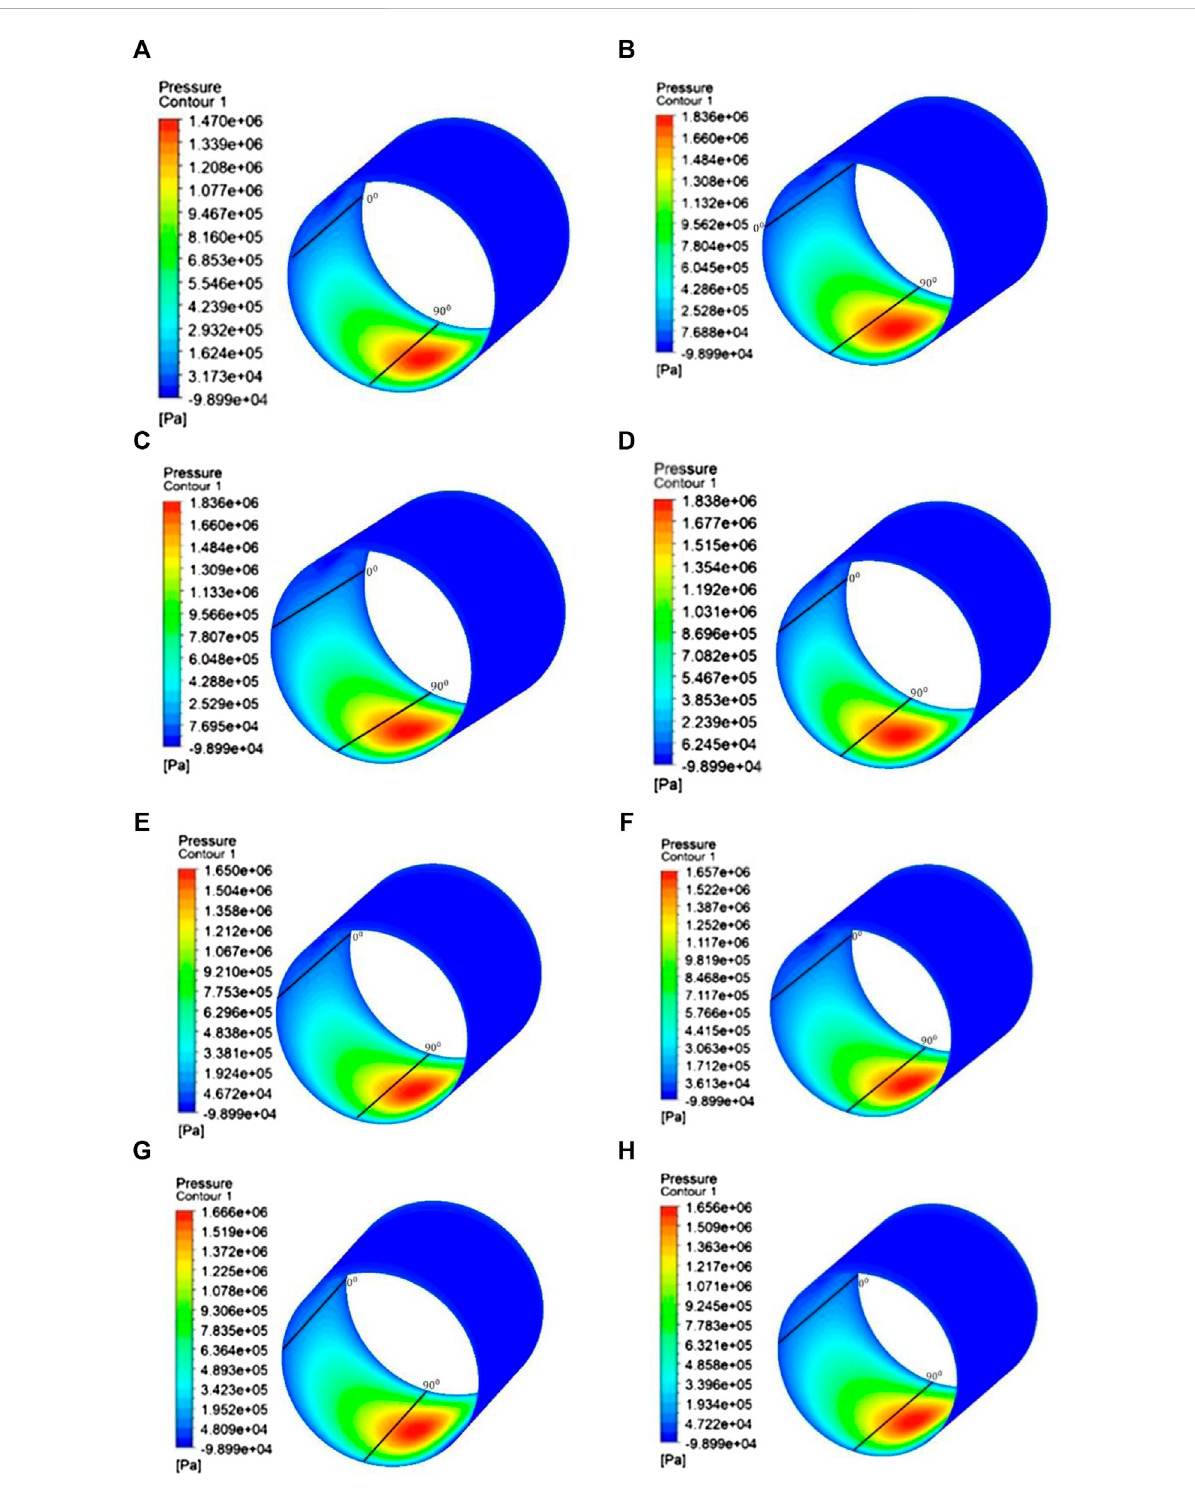
FIGURE 6 Contourofpressurefromthesmoothjournalbearingdengan, ε =0.7dan ω =3,000 rpm. (A) Laminar fl owandturbulence fl owwiththeviscosity model; (B) k-epsilon realizable; (C) k-epsilon RNG; (D) k-epsilon standard; (E) k-omega SST; (F) k-omegaBSL; (G) k-omegaGEKO;and (H) k-omega